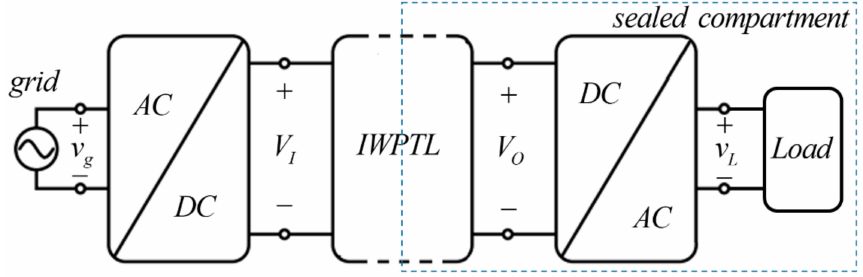
Figure 1. Wireless power delivery system based on SS-compensated